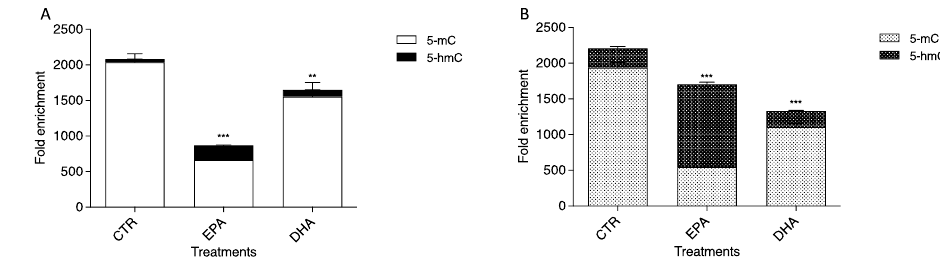
Figure 6. Effects of EPA and DHA on BDNF ( A ) and GDNF ( B ) methylation and hydroxymethylation levels. Experimental samples are reported as the mean ± SD. Data from three independent experi- ments using four independent cultures per condition were analyzed by ANOVA using Graphpad Prism software. ** p < 0.001, and *** p <